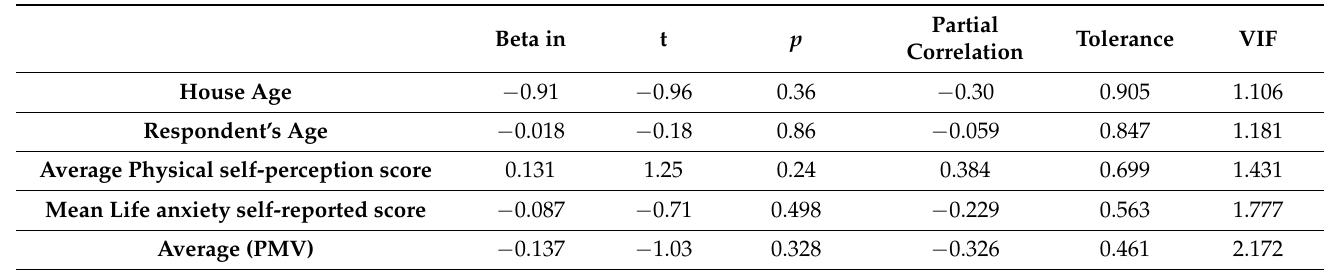
Table 13. Excluded variables for the best-fit final stepwise linear regression (backward) model with average total self-reported health problems score as the dependent variable for the data of 15 homes in the city of Toluca, State of Mexico,